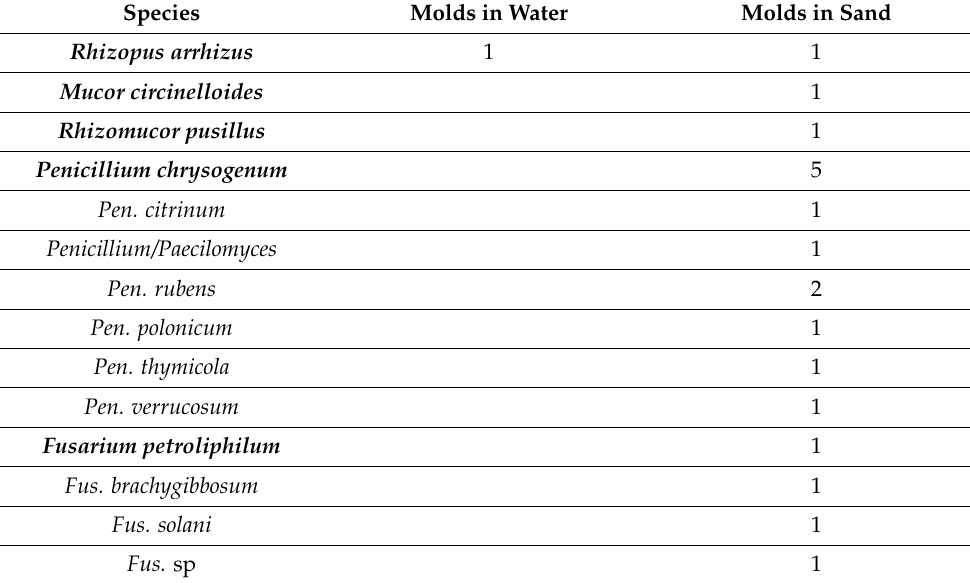
Table 1. Cont. Species Molds in Water Molds in